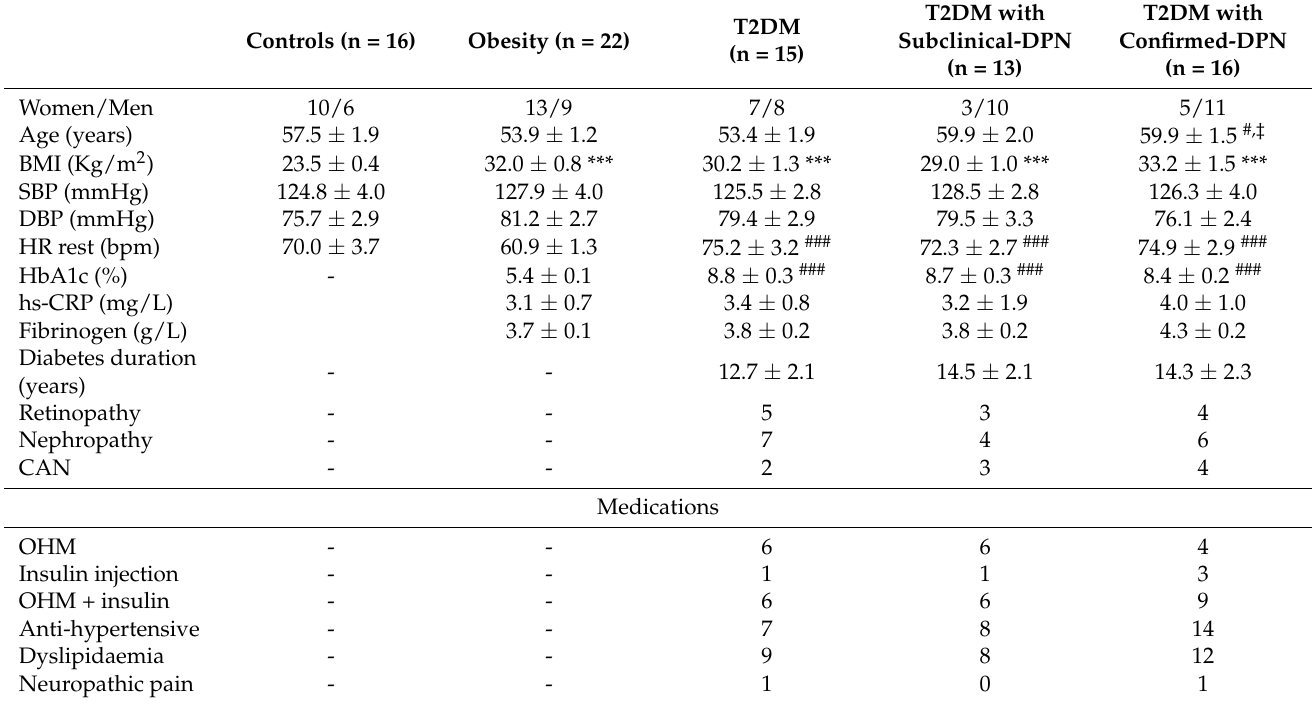
Table 1. Clinical characteristics of the